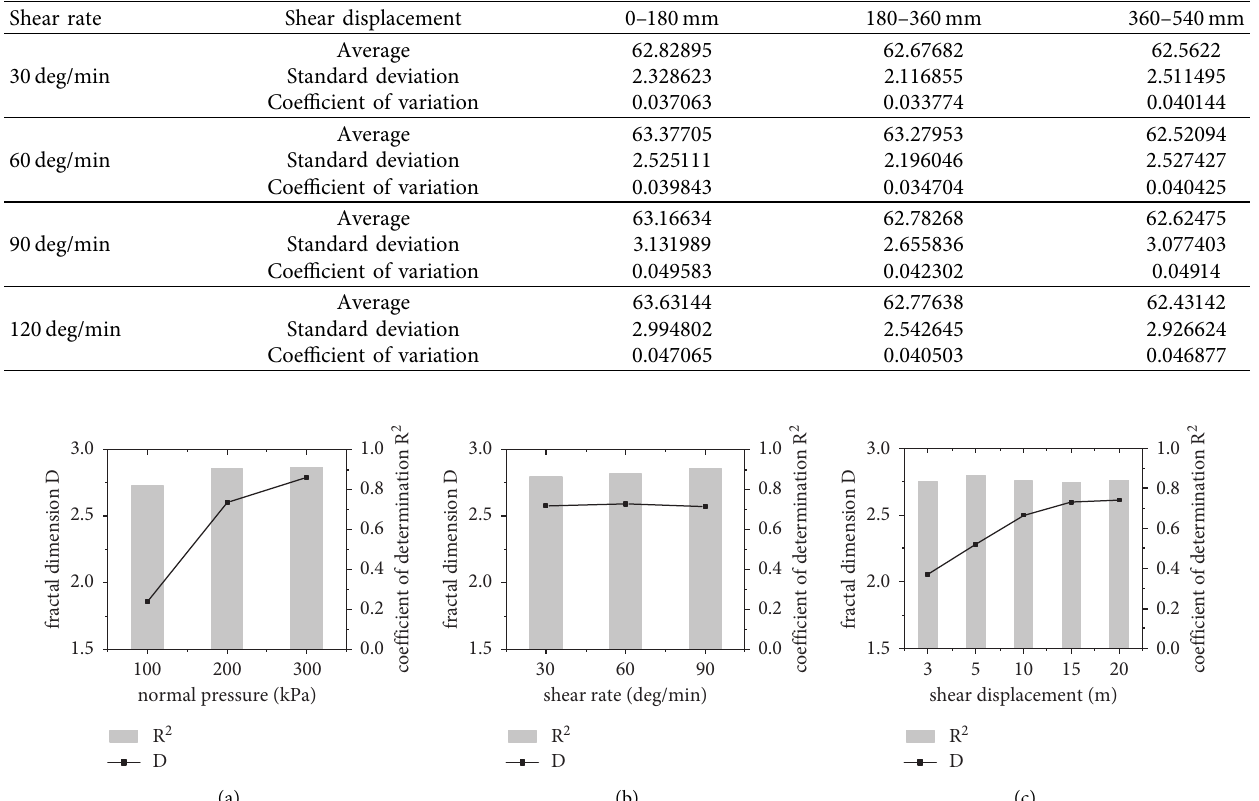
Table 5: Analysis of shear stress-displacement relationship.